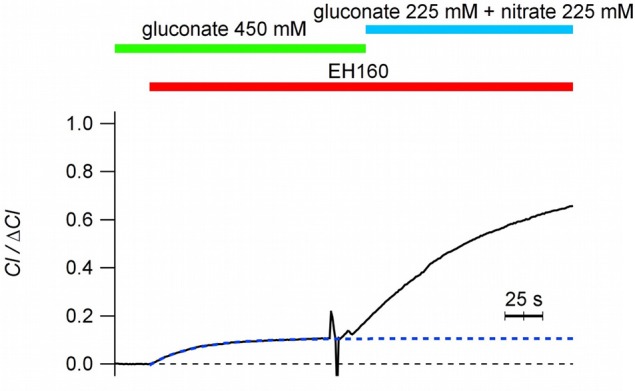
Time course of the external concentration of chloride induced by the anionophore EH160 with different external anions, as indicated in the figure. When gluconate is in the external solution, chloride efflux is small, and is arrested without reaching the equilibria of concentrations (internal Cl = 49.5 mM; external Cl = 0.099 mM). Further addition of nitrate, a permeable anion, restores the normal anionophore-induced chloride efflux. Data was normalized by the maximum anion change, ΔCl−.